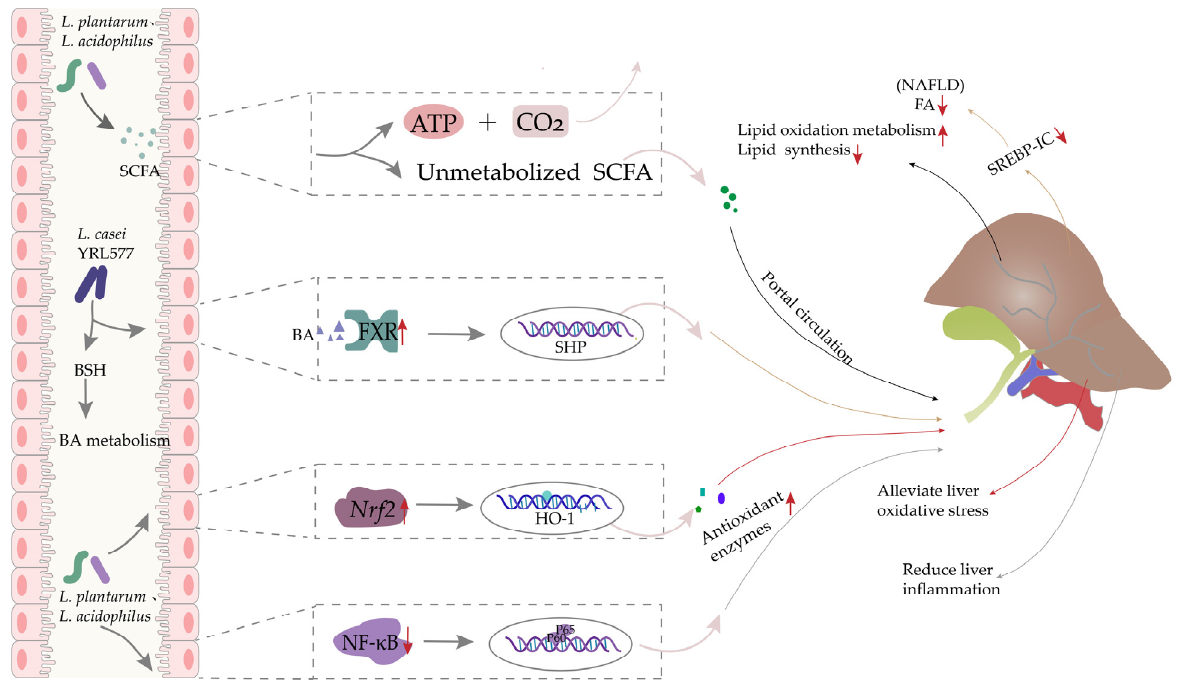
Figure 3. The effects of Lactobacillus treatment in oxidative stress-related liver disease. Some Lactobacillus regulate hepatic lipid metabolism and synthesis via SCFA production and the FXR/SHP/SREBP1c pathway, and some others reduce liver inflammation and oxidative stress through Nrf2 and NF- κ B pathways.